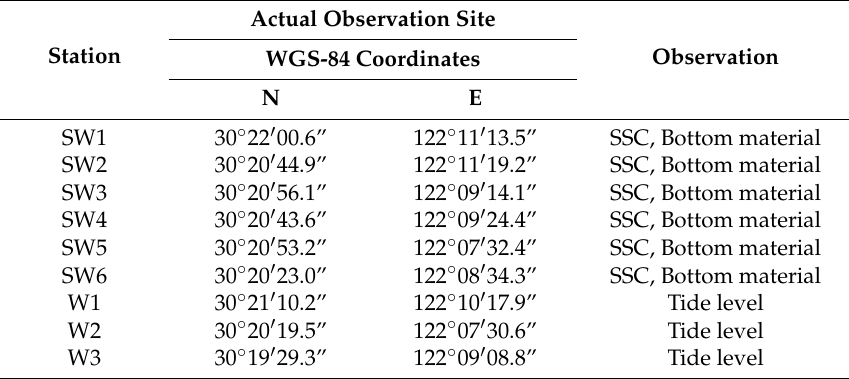
Figure 2. The engineering station of northern Daishan Island. Table 1. Coordinates of hydrological stations in the engineering sea area.